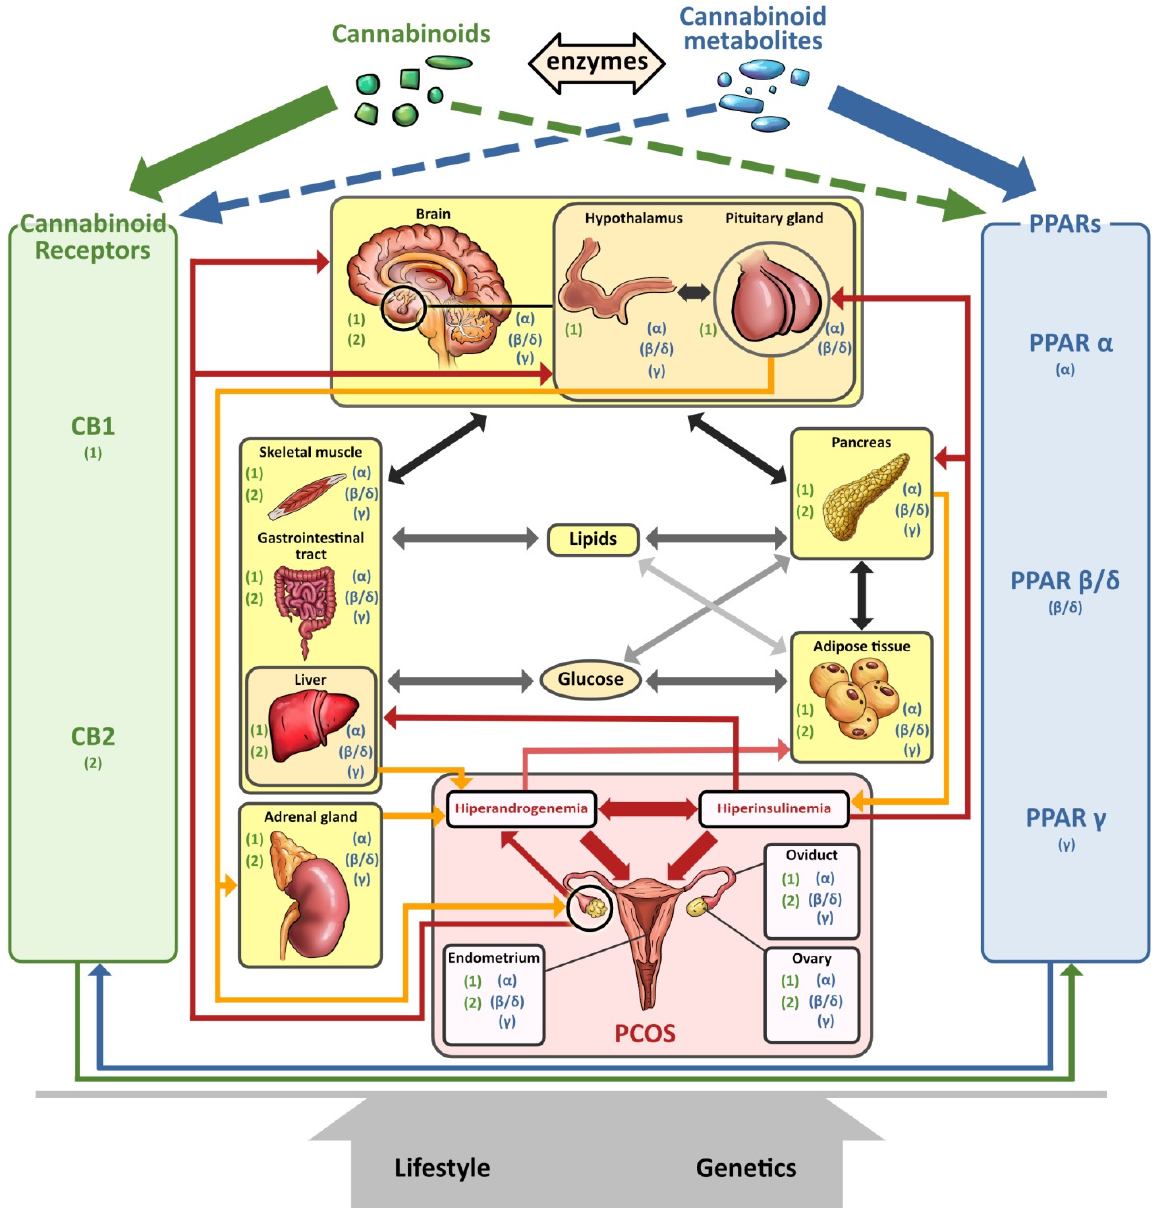
Figure 4. Pathophysiology of PCOS with presence of CBRs and PPARs in human tissues. Abbreviations: CB1Rm cannabinoid receptor type 1; CB2R, cannabinoid receptor type 2; PPAR, peroxisome proliferator-activated receptor.